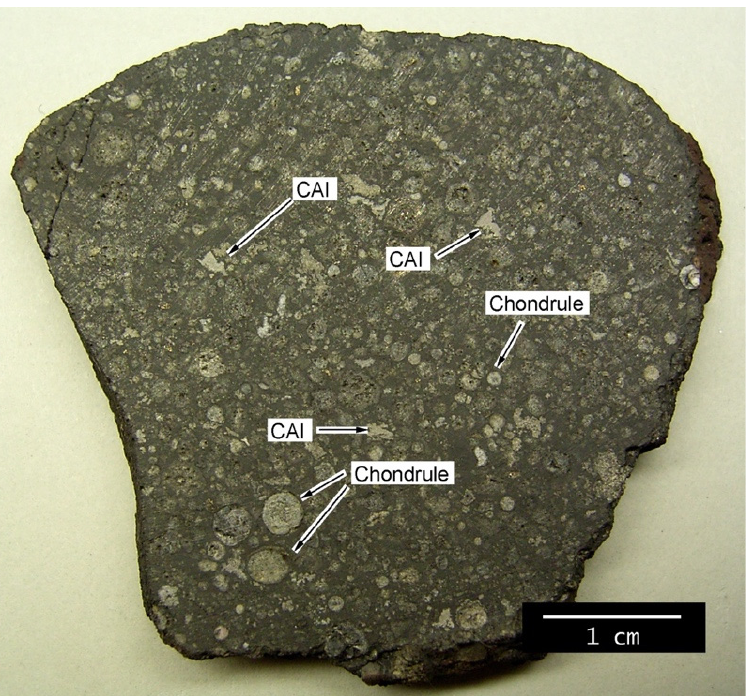
Figure 1. Photograph of the investigated Allende meteorite slab